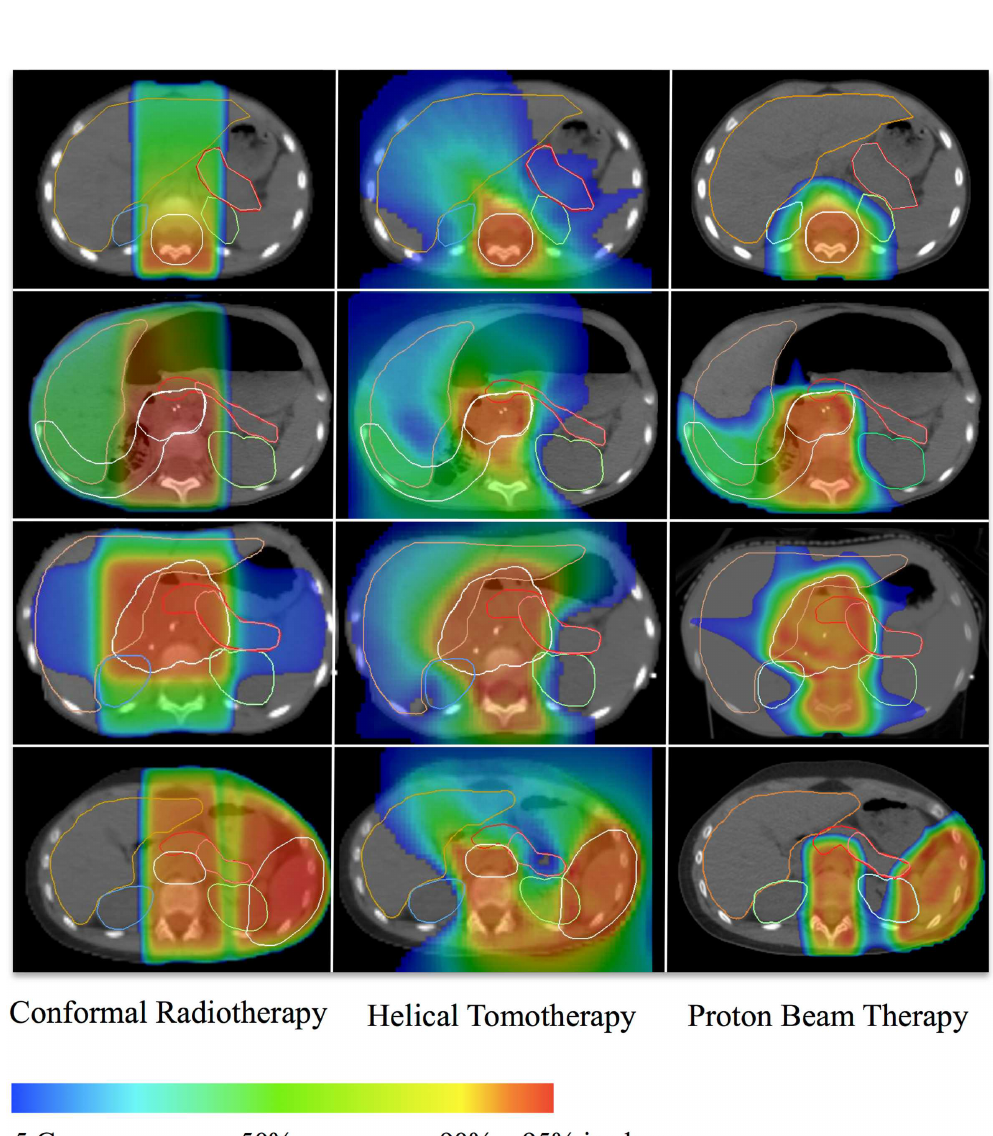
Fig 1. Dose distribution in four illustrative cases. A: medulloblastoma; B: right-sidednephroblastoma; C: median neuroblastoma; D: Hodgkinlymphoma. Left panel: conformal radiotherapy; right panel: helical tomotherapy. PTV contours (white). 95% isodoses (red); 90% isodose (yellow); 50% isodose (green); 5 Gy isodose